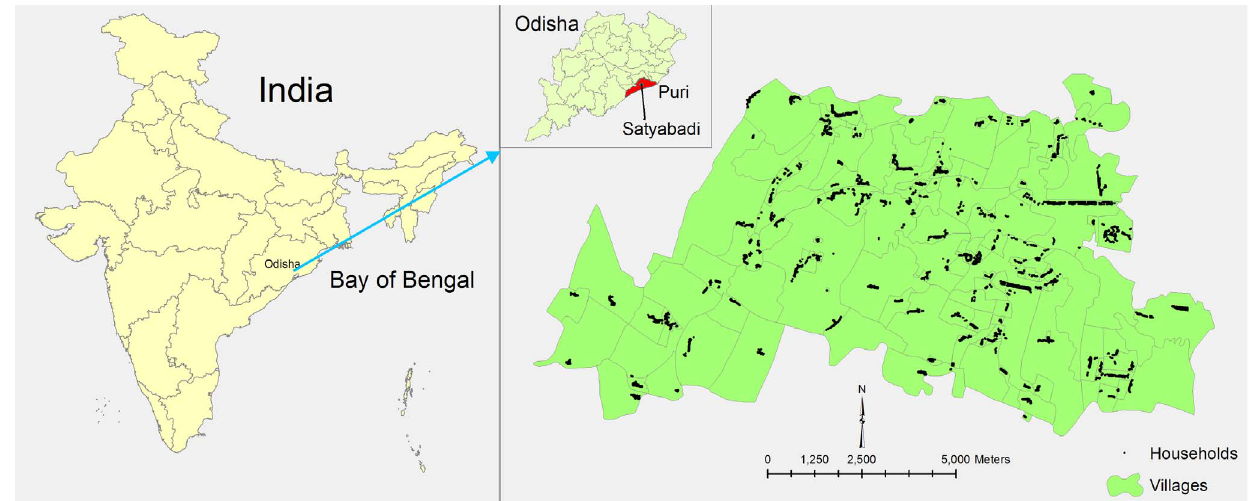
Figure 1. Study area in Satyabadi block, Odisha, India.